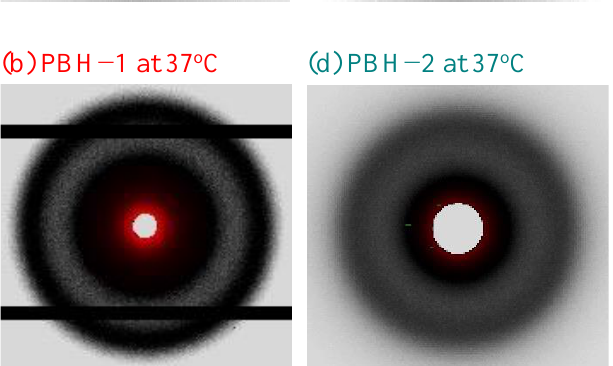
Figure 3. 2D-SAXS of the pluronic biomedical hydrogels at 25 °C and 37 °C, respectively.